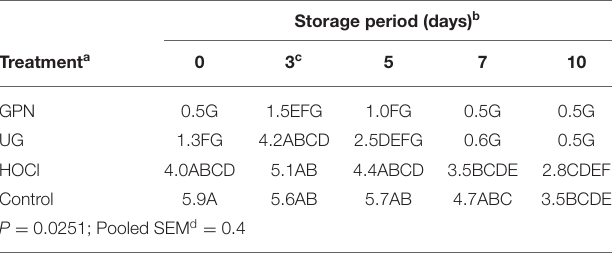
TABLE 2 | Least squares means of surviving Salmonella Typhimurium (log 10 CFU/cm 2 ) on spinach leaf surfaces by the interaction of antimicrobial treatment x storage